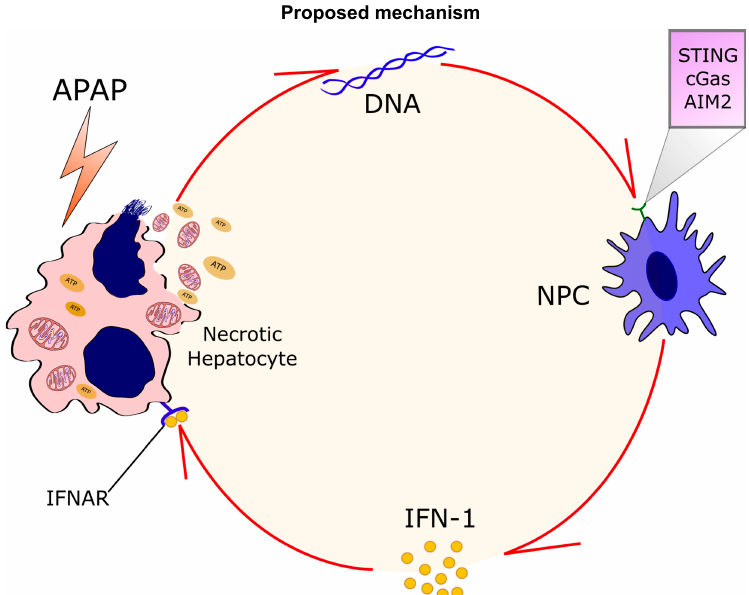
Figure 8. Proposed mechanism—APAP ‐ mediated liver necrosis leads to massive DNA release and deposition within the liver. IFN ‐ I ‐ mediated oxidative stress caused by liver NPCs is a master mediator of type 1 IFN ‐ induced liver damage. Therefore, controlling innate immune response during APAP ‐ mediated injury may dampen APAP ‐ triggered liver necrosis, paving a new road to further clinical interventions.